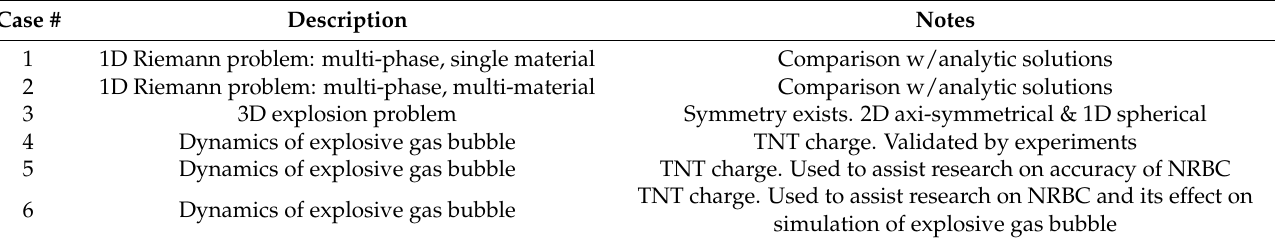
Table 6. Cases to be simulated using the UNDEXVT solver.